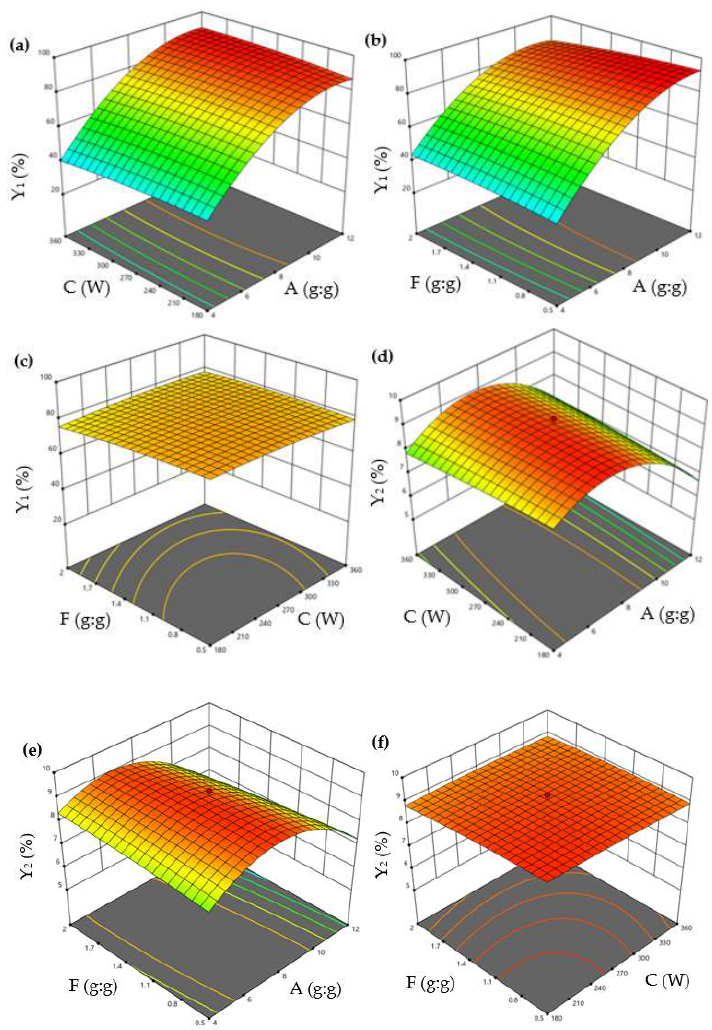
Figure 2. 3D surface plots showing interactions between A, C, and F on the Y 1 and Y 2 . ( a ) The in-